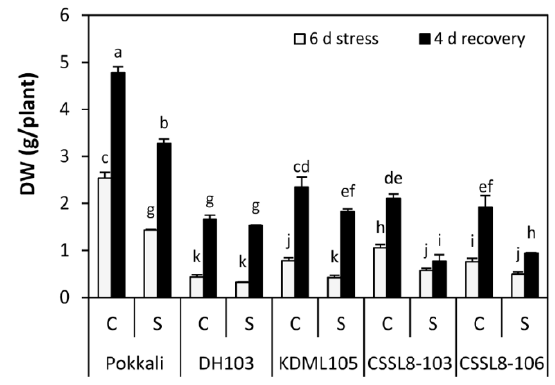
Figure 8. Dry weight (DW) of rice plants under control and salt stress for 6 days (light gray bars) and after recovery for 4 days (black bars). C, control; S, salt stress. For a description of the genotypes, see Figure 1. Values are means of four replications ± SE. Di ff erent letters indicate a significant di ff erence in the means of each group ( p ≤